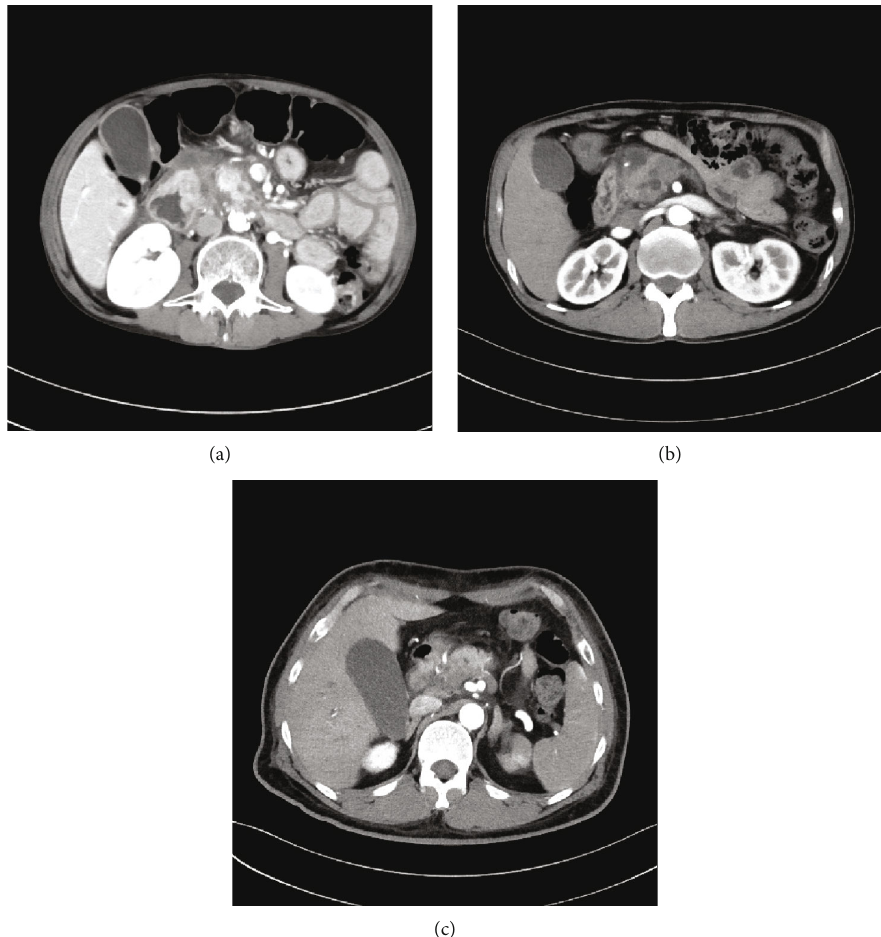
Figure 3: (a) Adenoma of duodenum. (b) Pancreatic cystadenocarcinoma. (c) Chronic pancreatitis with mass in pancreas